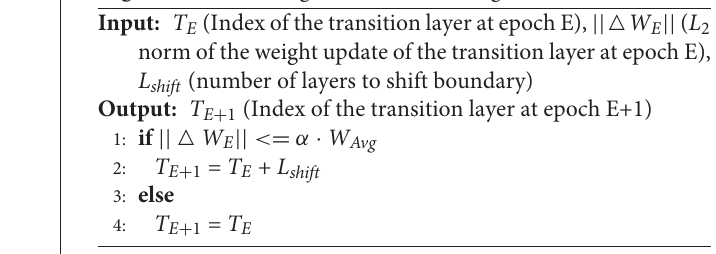
Algorithm 1 Learning Mode Selection